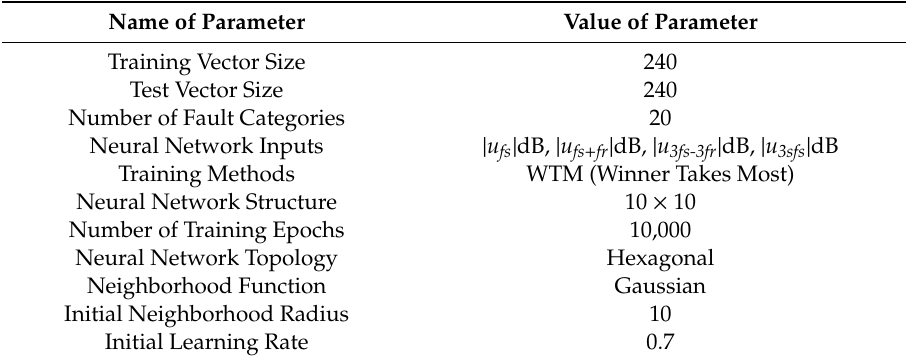
Table 5. Parameters of the SOM network and its training process.